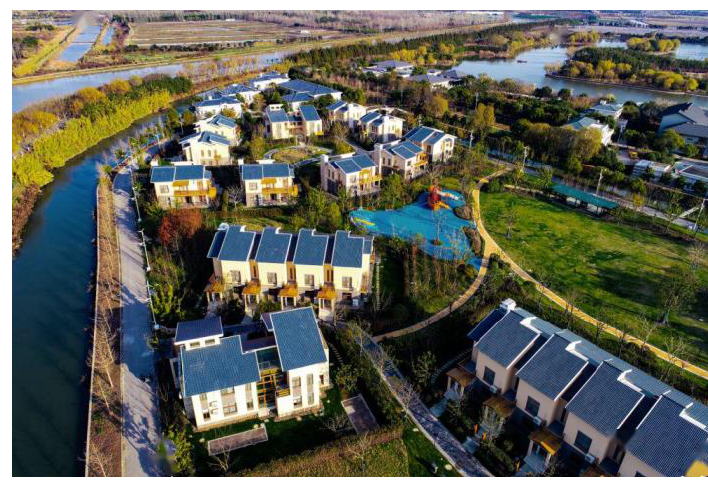
Figure 10. Aerial view of Beishuang village in Shanghai.